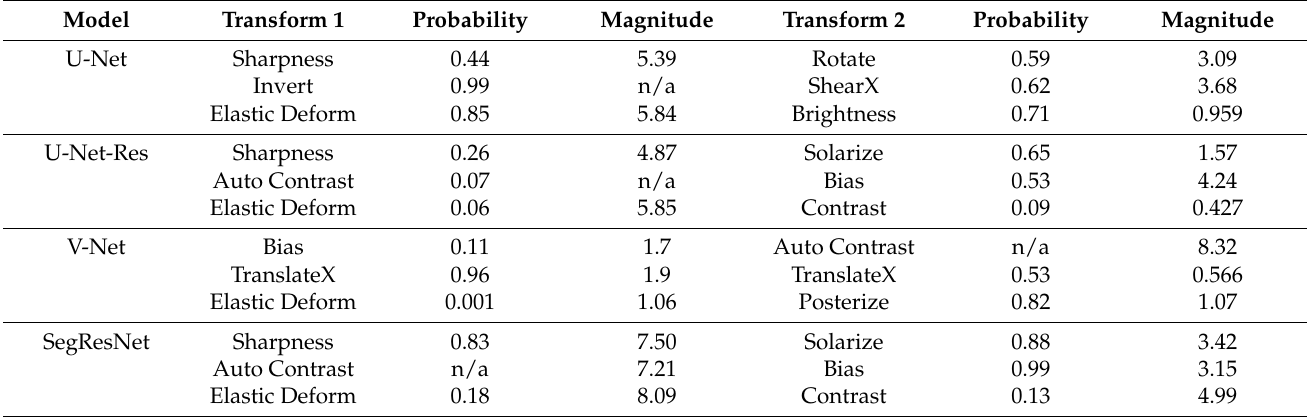
Table 3. Optimal policies selected by our Med-Aug search algorithm with the reduced BraTS dataset (Policies for the other datasets found by Med-Aug are listed in the Appendices B and